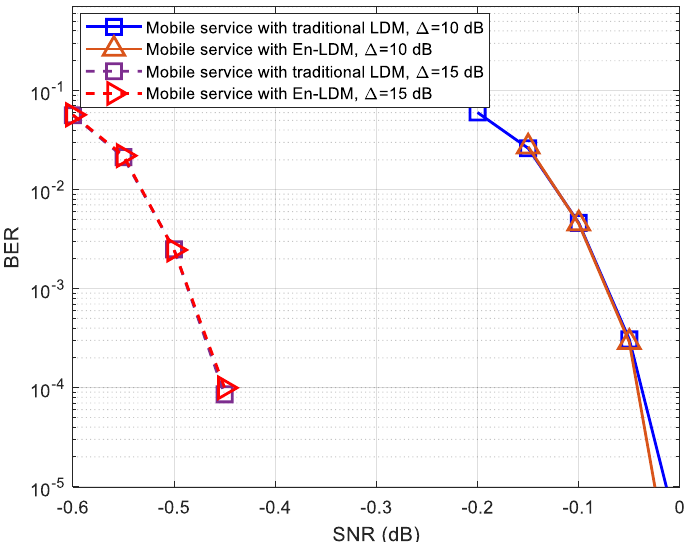
Figure 7. BER performance of mobile service with En-LDM and traditional LDM systems under the additive white Gaussian noise (AWGN) channel, where the injection levels were set to ∆ = 10 and 15 dB, the core layer (CL) constellation was set to QPSK, the enhanced layer (EL) constellation was set to NU−64QAM, the puncturing rate of the En-LDM scheme was set to 1/13, and the LDPC code rates of CL and EL were set to 5/15 and 11/15, respectively.